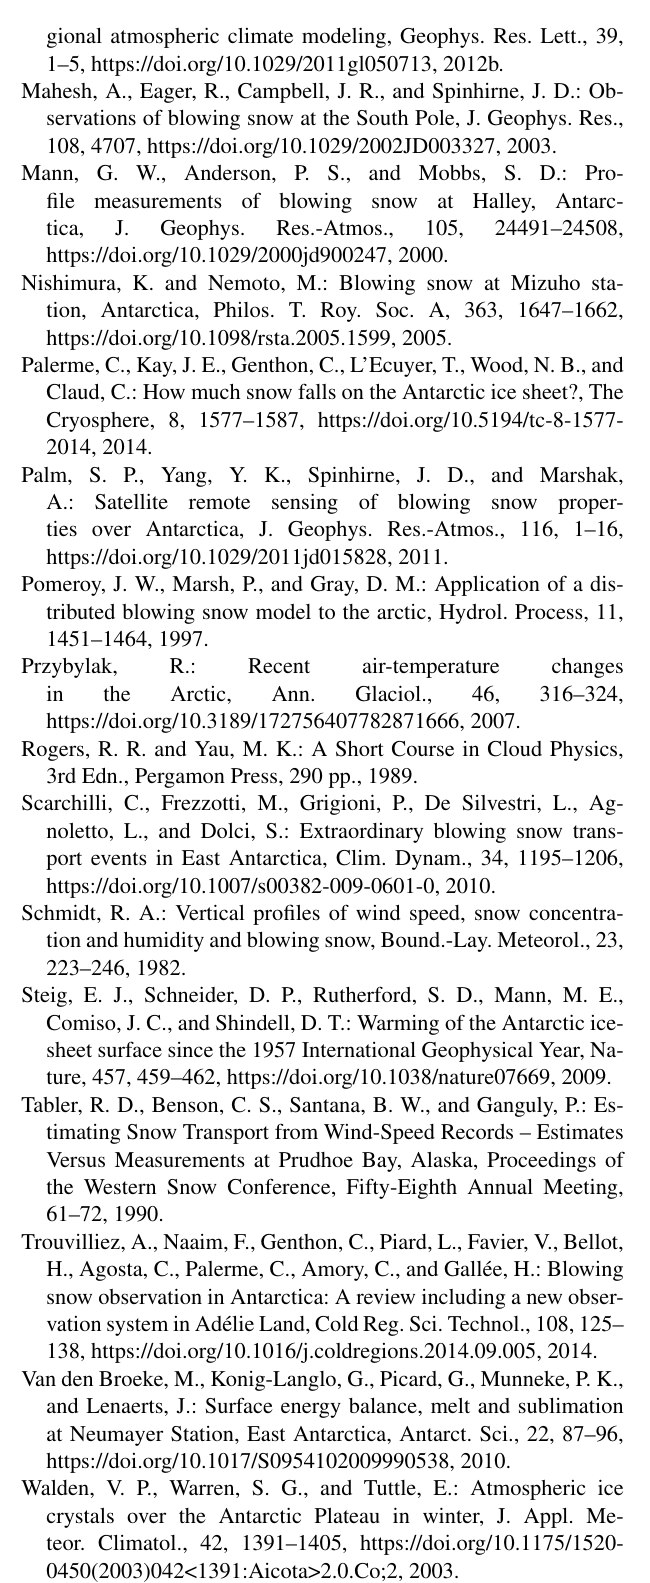
Tabler, R. D., Benson, C. S., Santana, B. W., and Ganguly, P.: